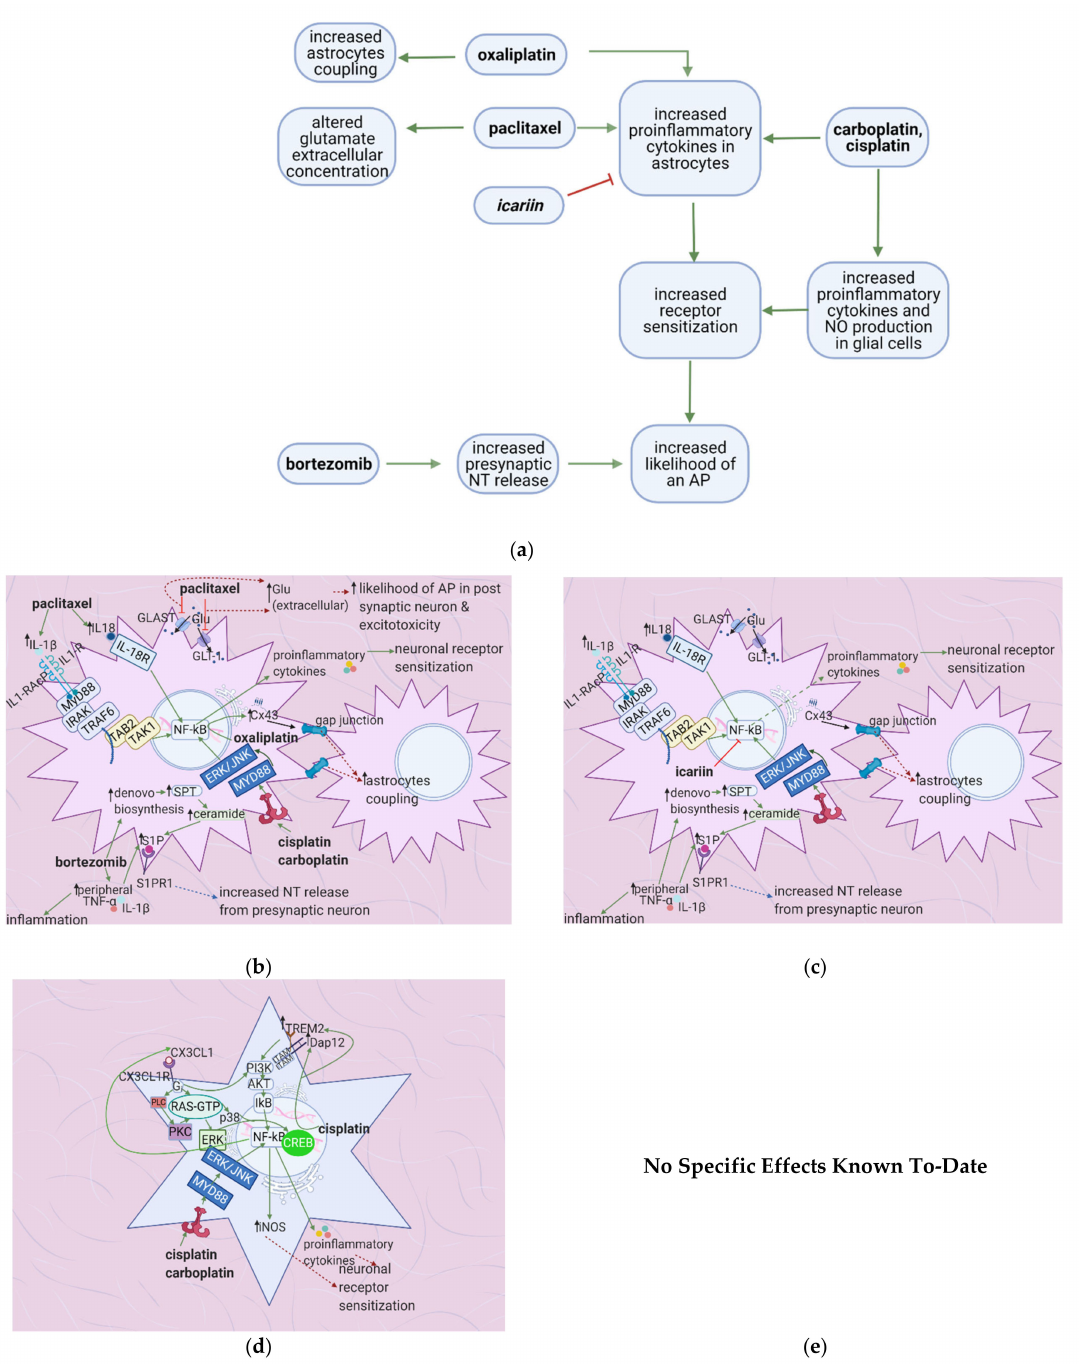
Figure 6. The actions of anticancer drugs (left) and flavonoids (right) on astrocytes and glial cells. ( a ) Simplified Overview of how flavonoids counteract the mechanisms of anticancer drugs at the level of astrocytes and microglial cells ( b ) Anticancer Drugs on Astrocytes. Anticancer drugs activate NF- κ B and consequently lead to the production of proinflammatory cytokines that sensitize neuronal receptors. Bortezomib increases the levels of S1P, which is hypothesized to increase presynaptic NT release. Paclitaxel blocks glutamate receptors, thus increasing its extracellular concentration and increasing the likelihood of an AP in the post-synaptic neuron. ( c ) Flavonoids on Anticancer Drug-Induced Increases in Proinflamma- tory Cytokines in Astrocytes. Icariin inhibits NF- κ B and thus counteracts the increase in proinflammatory cytokine levels, decreasing neuronal sensitization and inflammation. ( d ) Anticancer Drugs on Glial Cells. Anticancer drugs activate NF- κ B and CREB, leading to proinflammatory cytokines and NO production, ultimately causing neuronal receptor sensitization. ( e ) No specific effects of flavonoids on microglial cells are elucidated to-date. Studies usually investigate the spinal cord dorsal horn as a